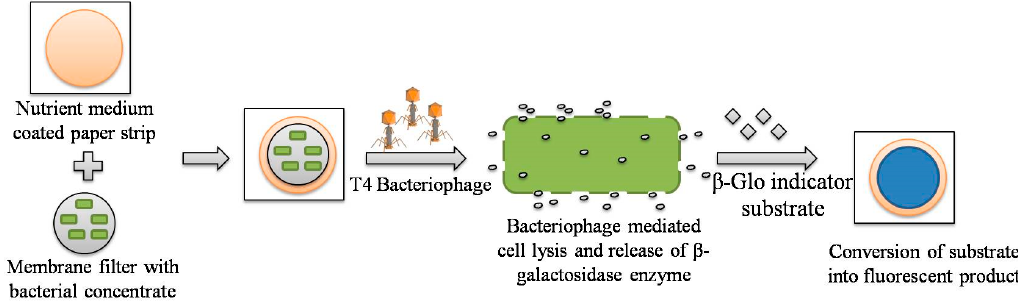
Figure 2. Principles for the detection of E. coli bacterial cells using a paper-based handheld culture Figure2. Principlesforthedetectionof E.coli device.